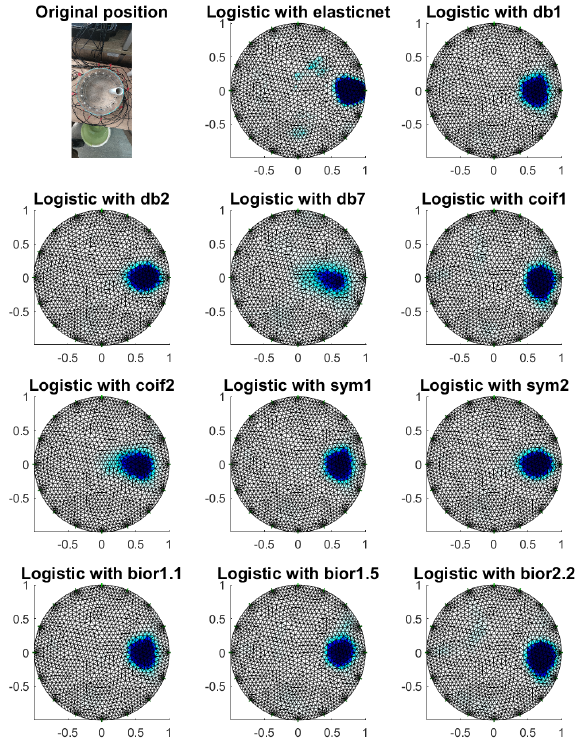
Figure 15. Image reconstruction with a phantom at electrode 5.